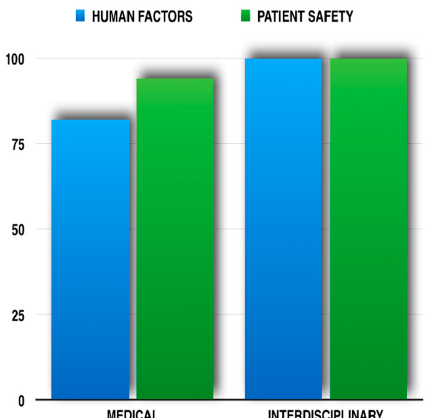
Figure 1. Module Feedback (80% response rate)—Student perception of improved knowledge (5-point Lickert scale) in: ( Left ) Human Factors specifically and ( Right ) Patient Safety in general.